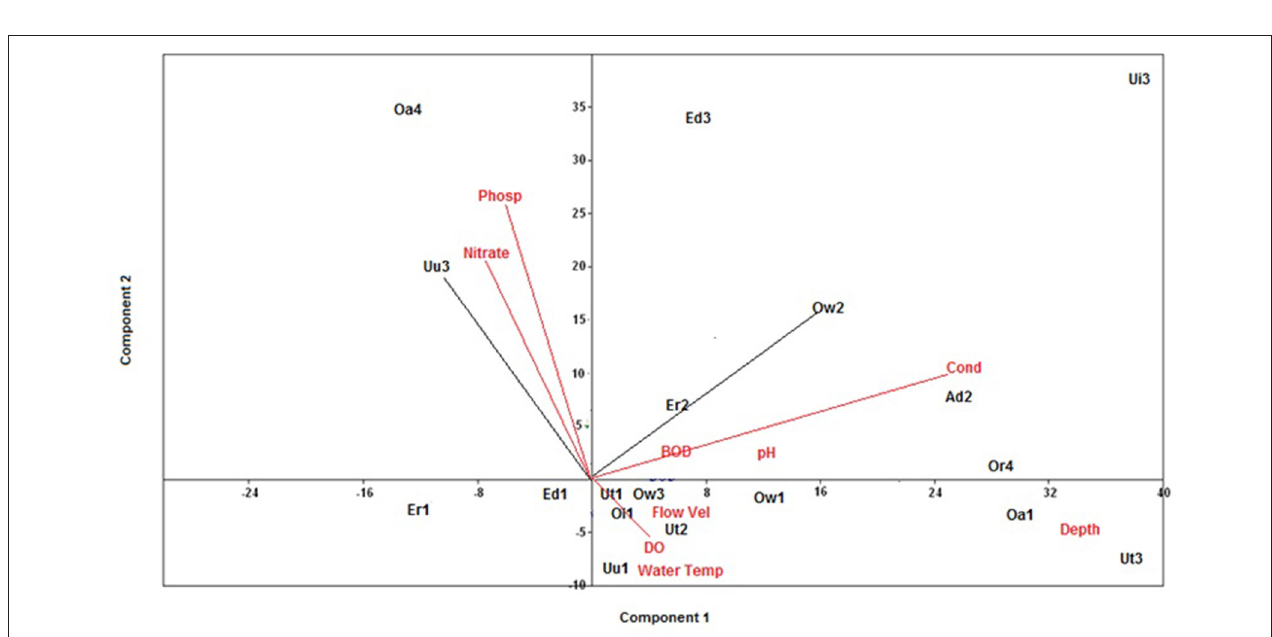
FIGURE 2 | PCA visualizing the 18 stations correlation with selected physico-chemical variables. Water Temp, Water temperature; Flow Vel, Flow velocity; DO, Dissolved oxygen; BOD, 5-day biochemical oxygen demand; Cond, Electrical conductivity; Phosp, phosphate.